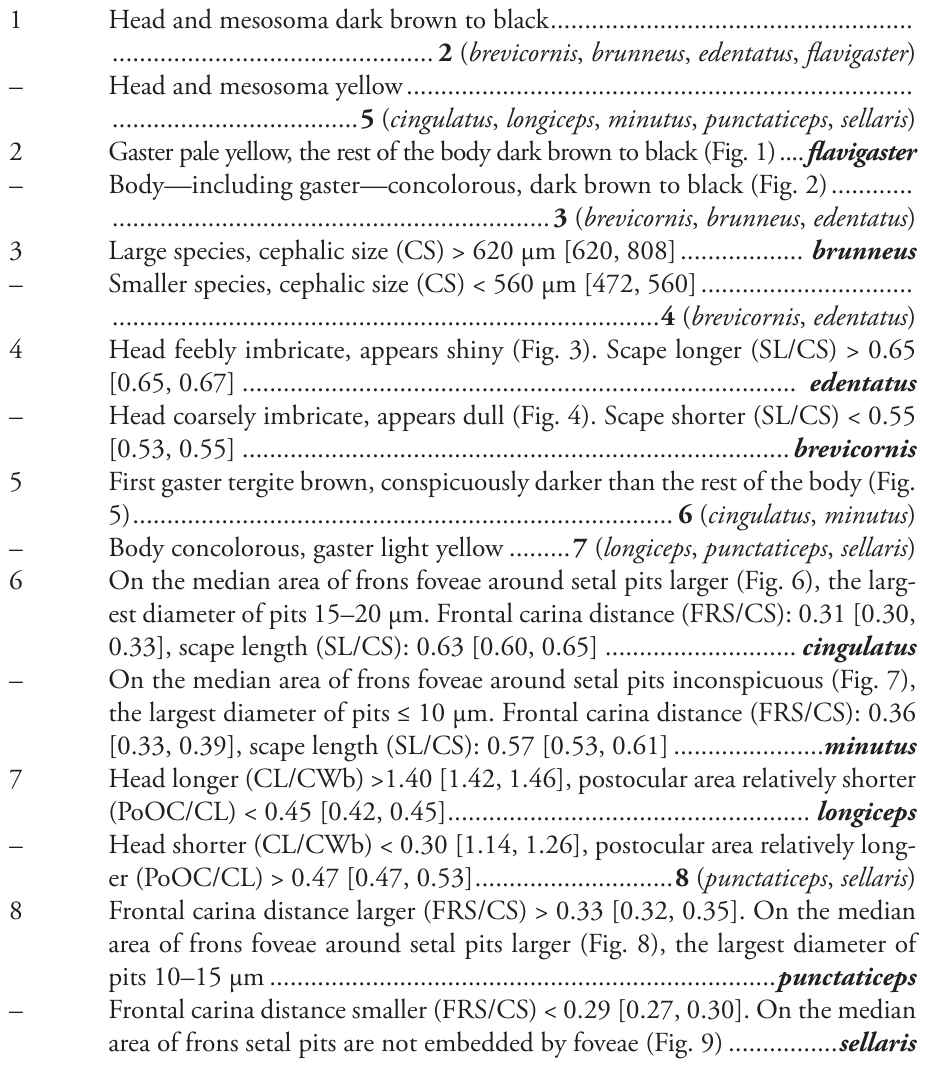
Type material investigated. Holotype: CASENT0027494 , collection